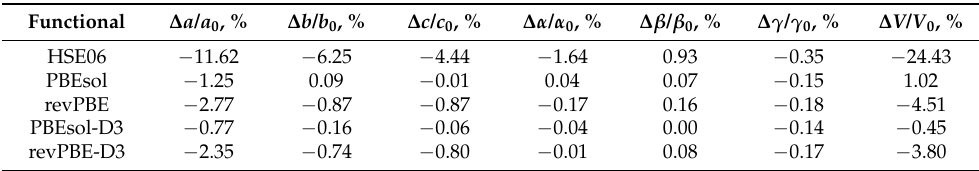
Table 1. Relative errors in determining the crystallographic parameters of the CPO-27-Mg cell using various density functional theory (DFT)